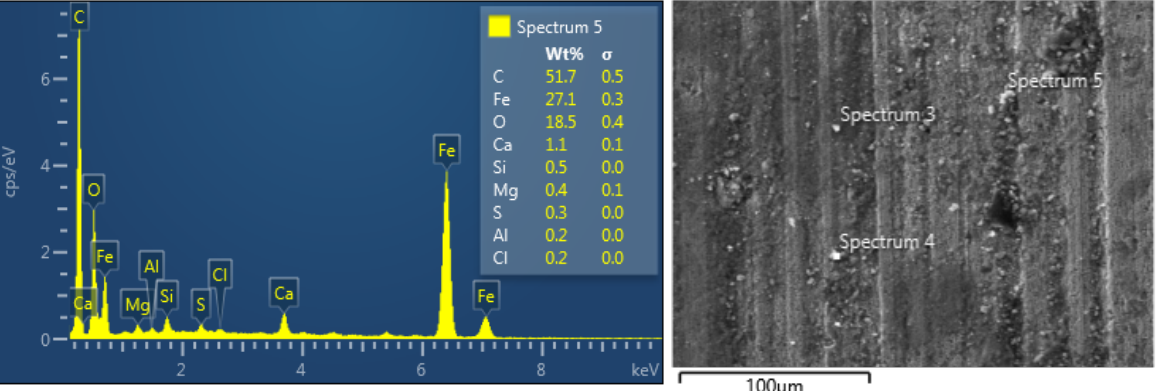
Figure 8. SEM images of a P110 worn casing sample (S1) tested under wet conditions (oil-based drilling fluid) at 115 rpm and 1400 N. Table 4. The composition of the oil-based drilling fluid, as received from the oil company labs.